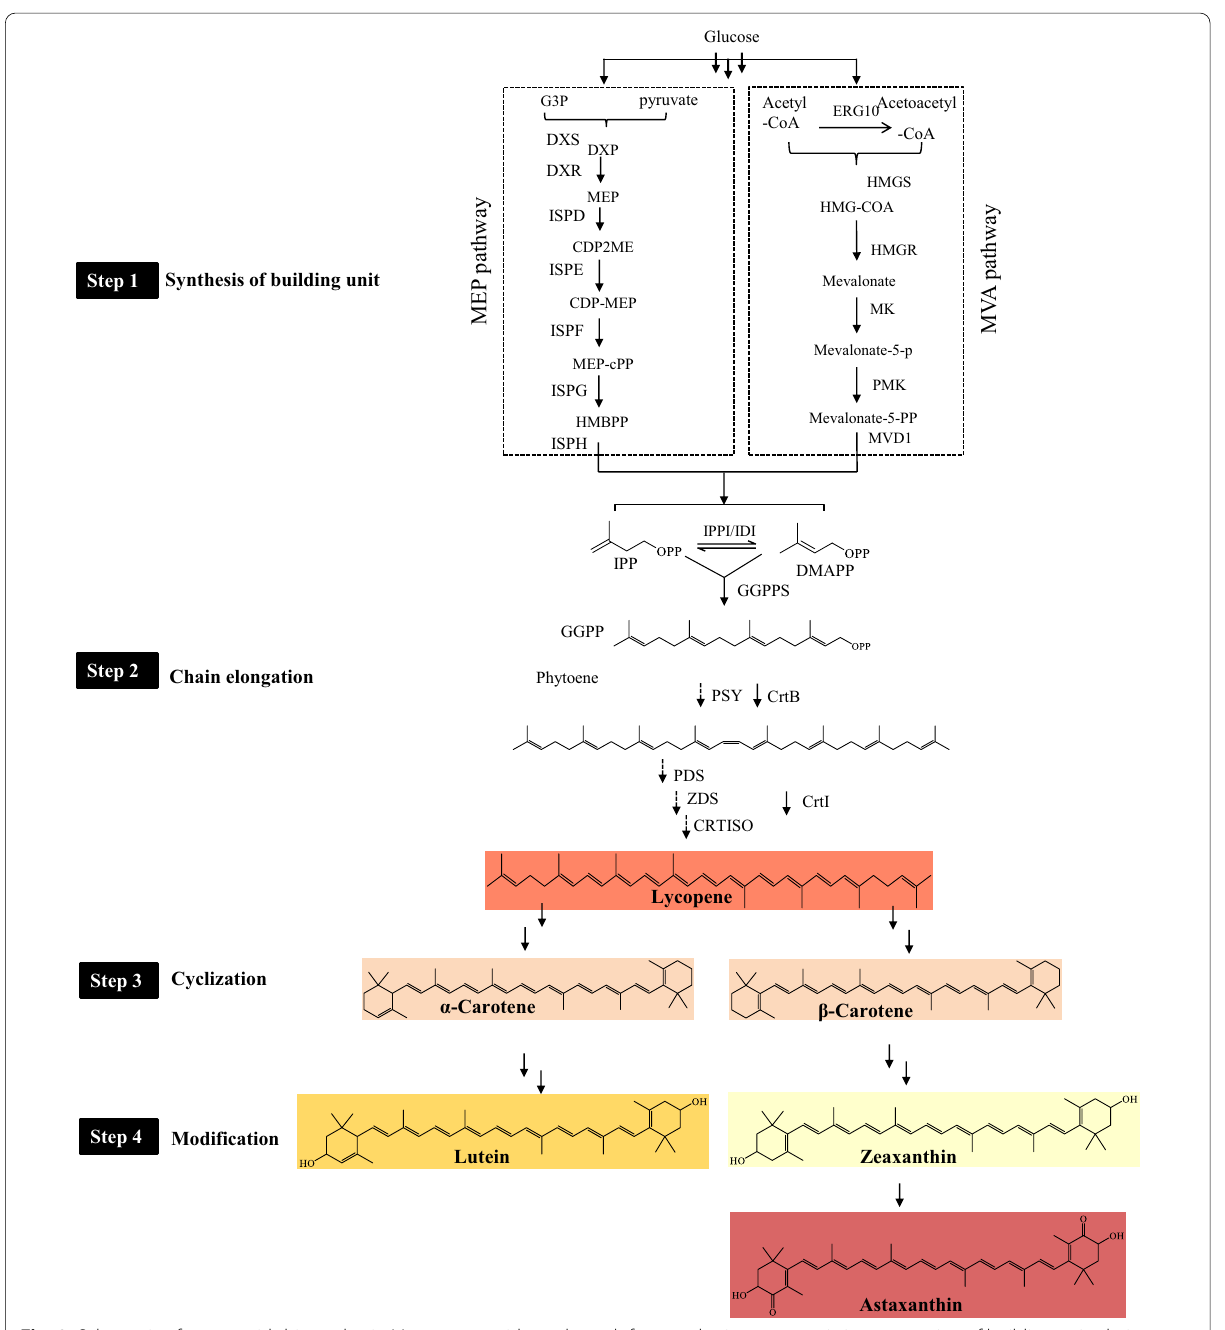
Fig. 8 Schematic of carotenoids biosynthesis. Most carotenoids go through four synthetic steps consisting generation of building unit, chain elongation, cyclization, and modification. DXS, 1-deoxy-d-xylulose-5-phosphate synthase; DXR, 1-deoxy-d-xylulose-5-phosphate reductoisomerase; ISPD, 4-diphosphocytidyl-2C-methyl-D-erythritol synthase; IspE, 4-diphosphocytidyl-2-C-methyl-D-erythritol kinase; IspF, 2C-methyl-D-erythr itol-2,4-cyclodiphosphate synthase; IspG, 1-hydroxy-2-methyl-2-(E)-butenyl-4-diphosphate synthase; IspH, 1-hydroxy-3-methyl-2-(E)-butenyl -4-diphosphate reductase; HMGS, HMG-CoA synthase; HMGR, HMG-CoA reductase; MK, mevalonate kinase; PMK, phosphomevalonate kinase; MVD1, mevalonate diphosphate decarboxylase; IPPI/IDI1, isopentenyl-diphosphate isomerase; GGPPS, GGPP synthase; PSY, phytoene synthase; PDS, phytoene desaturase; ZDS, ζ ‐ carotene desaturase; CRTISO, carotenoid isomerase; CrtB, phytoene synthase; CrtI, phytoene desaturase; DXP, 1-deoxy-D-xylulose-5-phosphate; MEP, 2-C-methyl-D-erythrito-l4-phosphate; CDP2ME, 4-diphosphocytidyl-2-C-methylerythritol; MEP-cPP, 2-C-met hyl-D-erythritol-2,4-cyclo-diphosphate; HMBPP, (E)-4-hydroxy-3-methylbut-2-enyl-diphosphate; IPP, isopentenyl diphosphate; DMAPP, dimethylallyl diphosphate; GGPP, geranylgeranyl